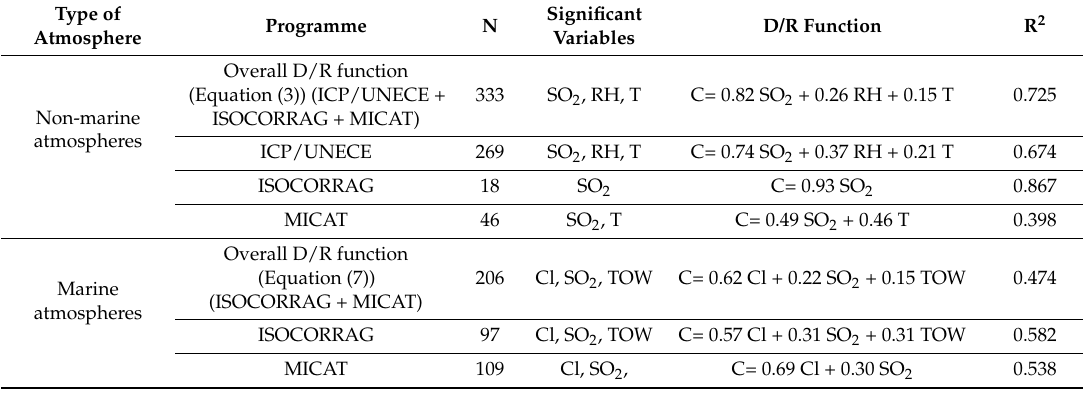
Table 9. D/R functions for first-year corrosion of carbon steel. Contribution of the information supplied by each of the international programmes to the overall D/R functions (Equations (3) and (7)) using the integrated